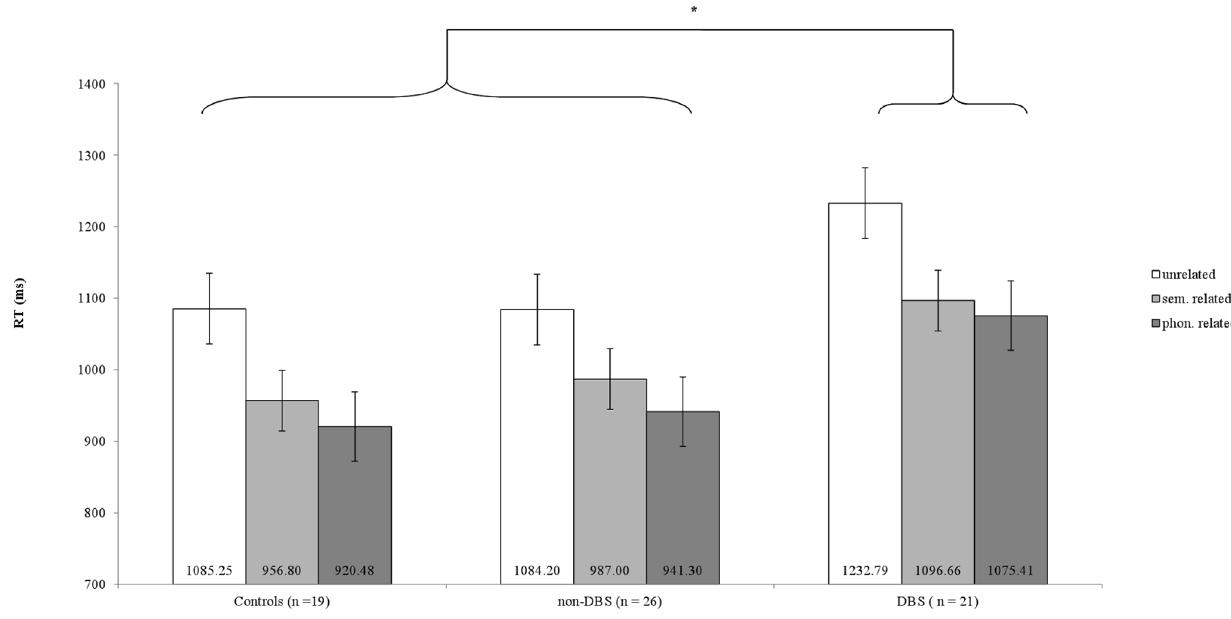
Figure 2. Lexical Decision Task. Reaction time in LDT indicated for the three stimulus conditions for controls and both patient groups (each ON therapy). DBS patients showed significantly longer RTs than controls and non-DBs patients. Shortest RTs were consistently obtained for phonemically related words. Values indicate the mean RT, bars the standard error, an asterisk a statistically significant differnces ( p , .05).